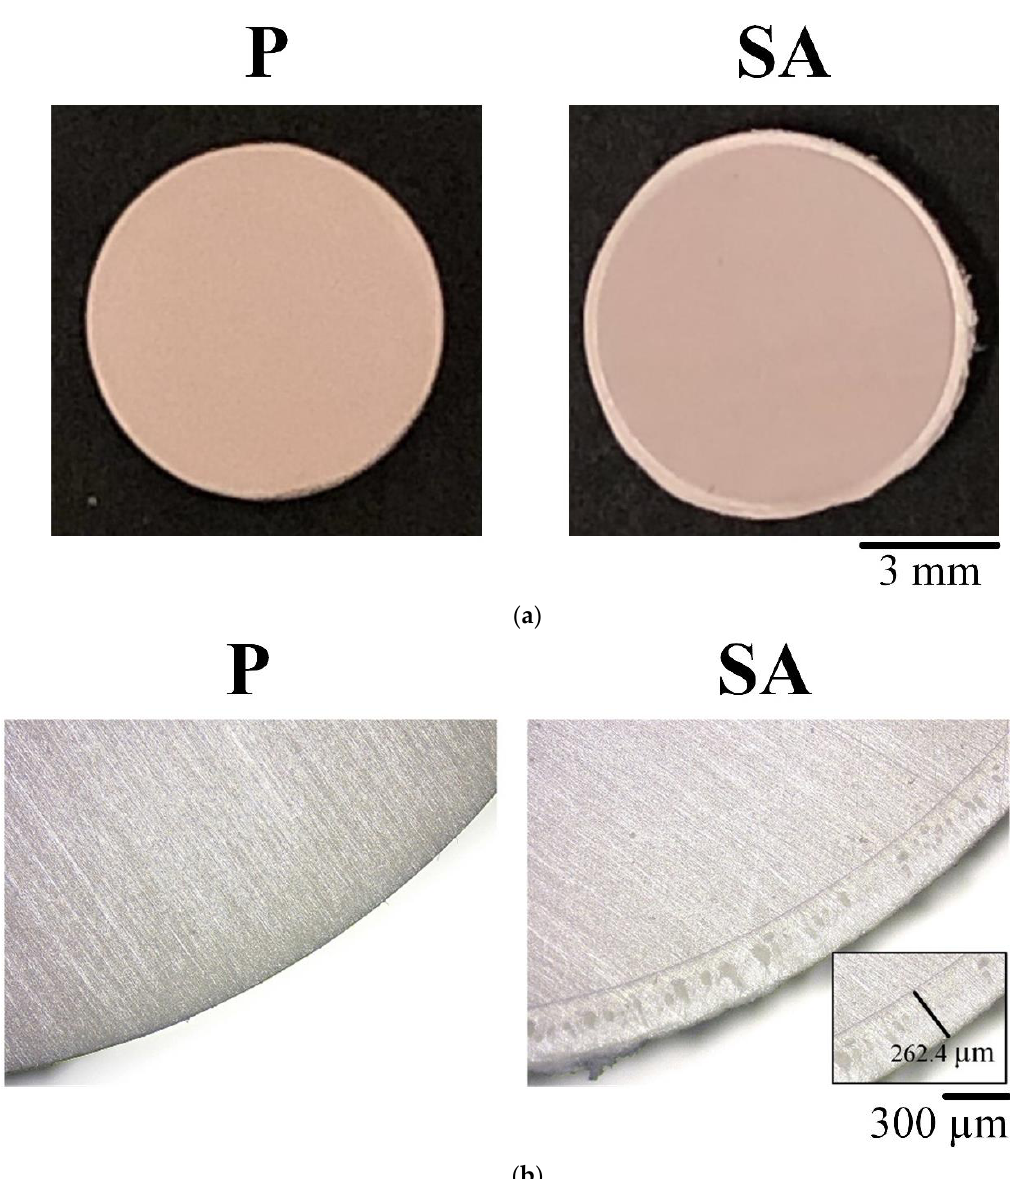
Figure 2. Cross-sectional observations of unmodified PEEK of the P group and sulfonated PEEK of the SA group: ( a ) photos and ( b ) OM images.